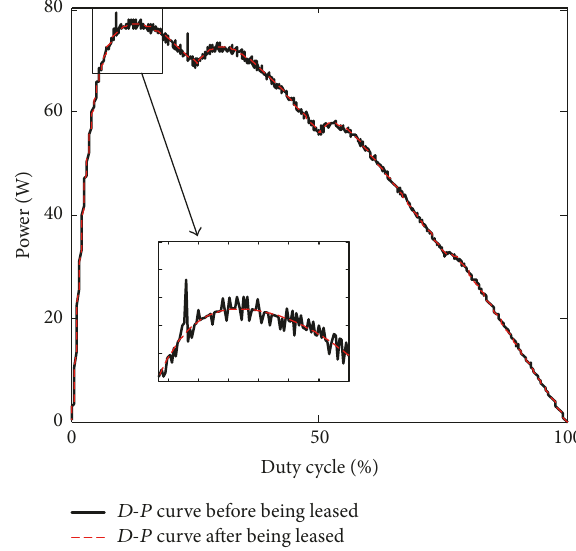
Figure 3: D - P characteristics after least square of